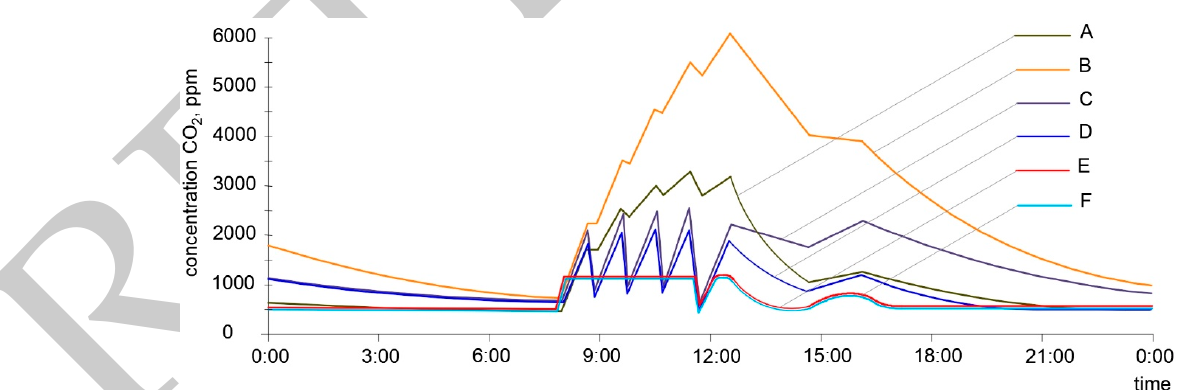
Table 1. Amount of ventilation air changes in the school.